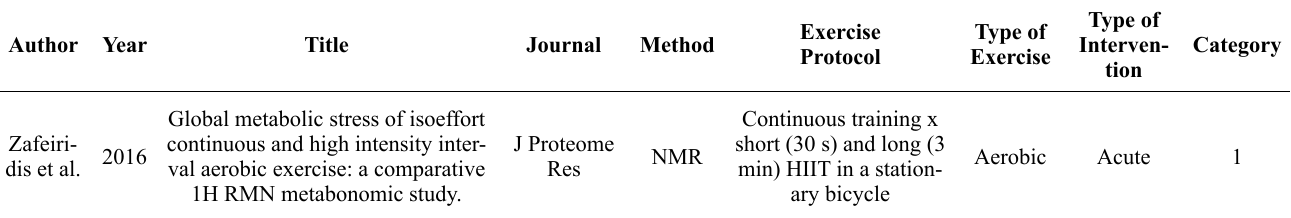
Figure 4. Percentages for the number of publications by category of classification regarding the subject of investigation. Table 1 – Articles selected after a systematic